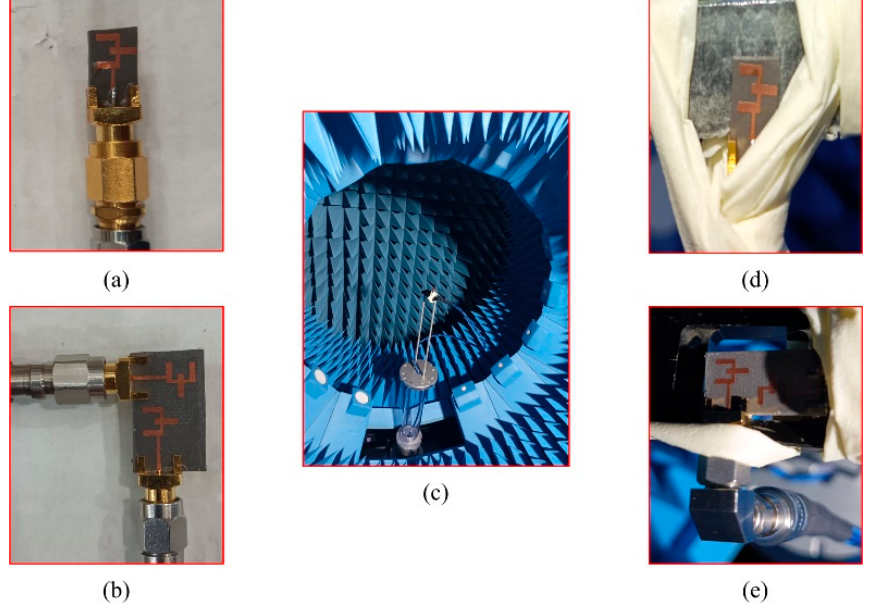
Figure 5. S-parameter measurements of ( a ) single-element ( b ) MIMO-antenna. ( c ) Far-field meas- urement setup, ( d ) single element and ( e ) MIMO element.